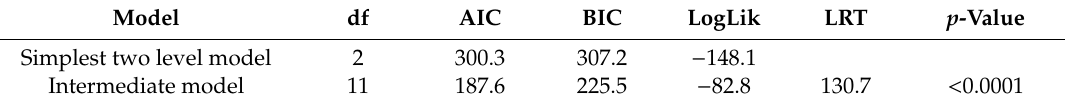
Table 2. Likelihood ratio test (LRT): The simplest two level model and intermediate model. Model df AIC BIC LogLik LRT p -Value Simplest two level model 2 300.3 307.2 − 148.1 Intermediate model 11 187.6 225.5 − 82.8 130.7 < 0.0001 Note: The AIC (Akaike information criterion) and the BIC (Bayesian information criterion) are the well-known model fit